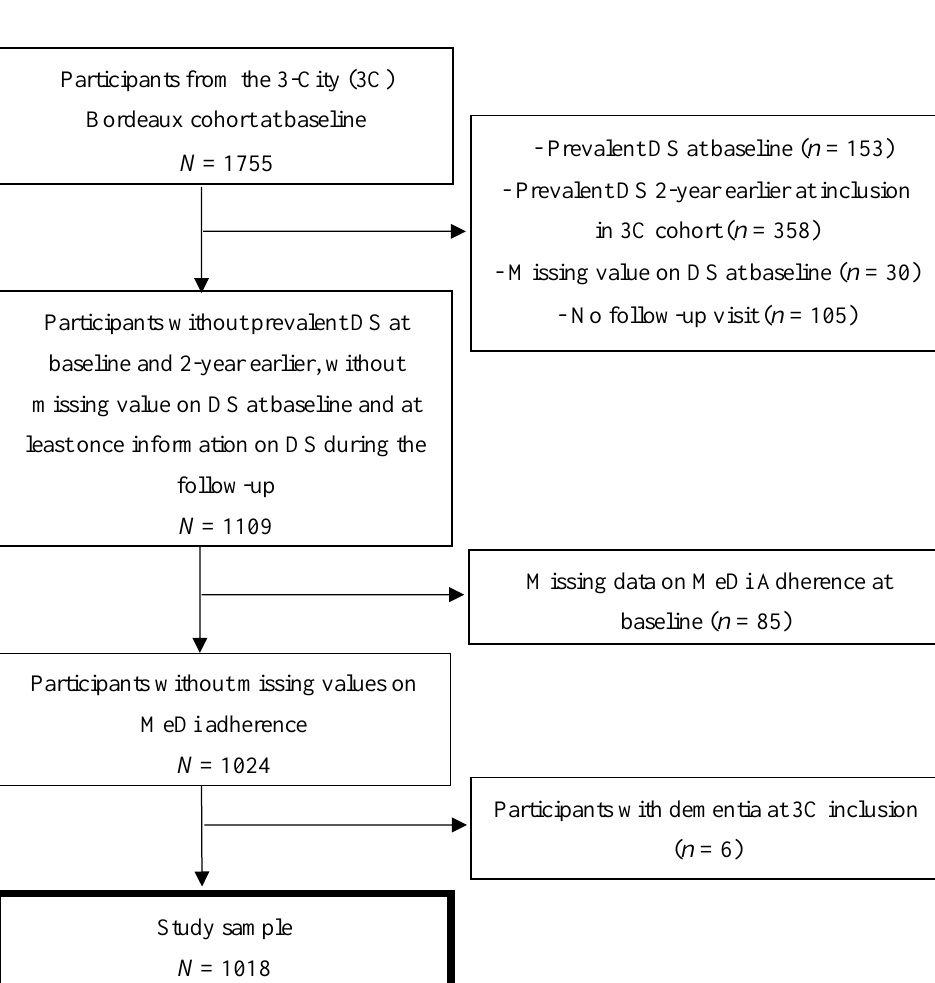
Figure 1. Flowchart of study of the association between adherence to the Mediterranean diet and the incidence of depressive symptomatology in a population aged 65 years and over. Three-City Bordeaux cohort, 2001–2017; DS = depressive symptomatology; MeDi = Mediterranean diet.